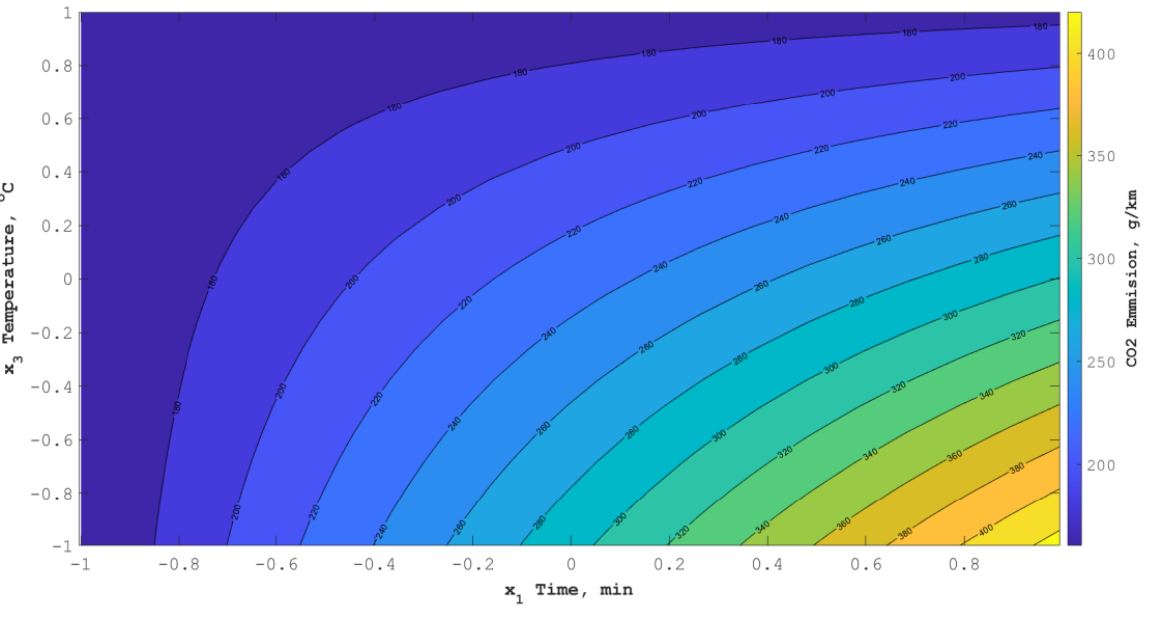
Figure 6. Change in CO 2 emissions depending on the variability of factors x 1 and x 3 for a vehicle (ICE) covering a distance of 3 km (x 2 = 0).